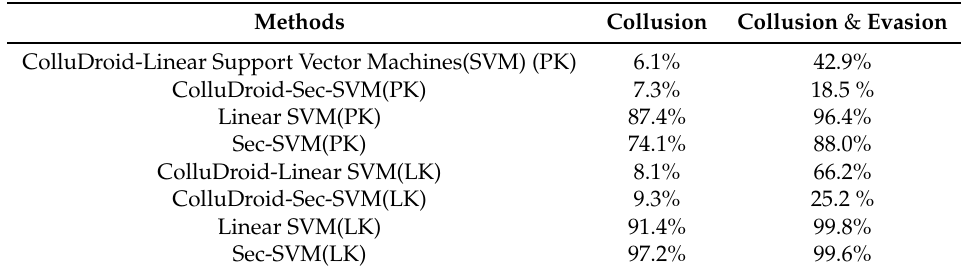
Table 2. Results under collusion attack, evasion